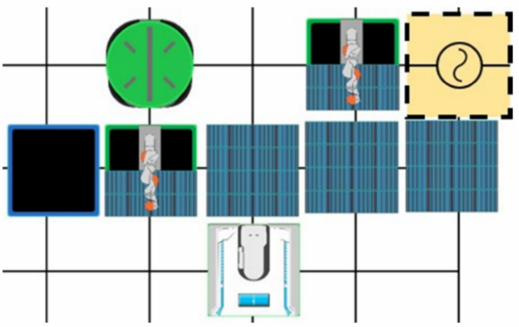
Figure 8. A manufacturing island with direct access to modular